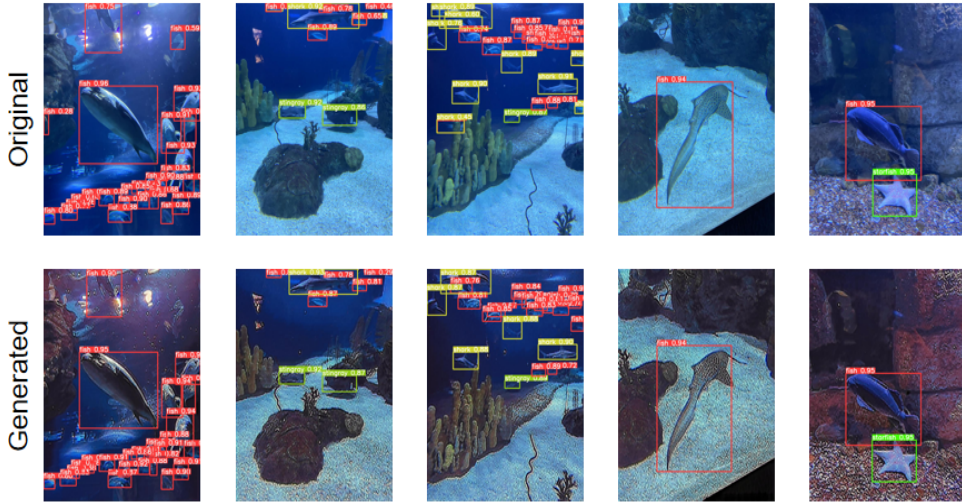
Figure 13. Object detection results on Aquarium Combined dataset.